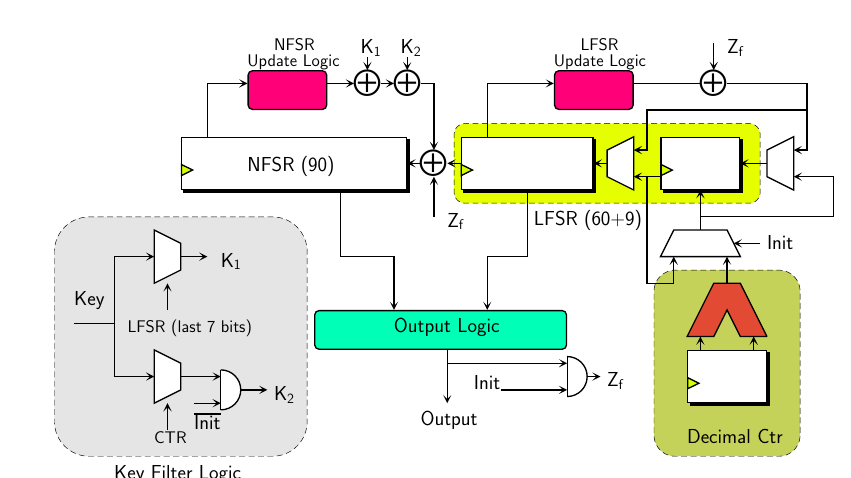
Figure 5: High level Circuit Diagram. Note that the logic required to load the IV and constant pad on to the registers is not explicitly